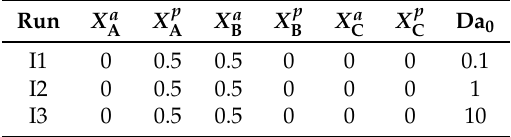
Table 1. Parameters of the initial distribution of species mixing ratios of Equation (49) and initial Damk¨ohler number for various runs while using the ideal chemistry (54).